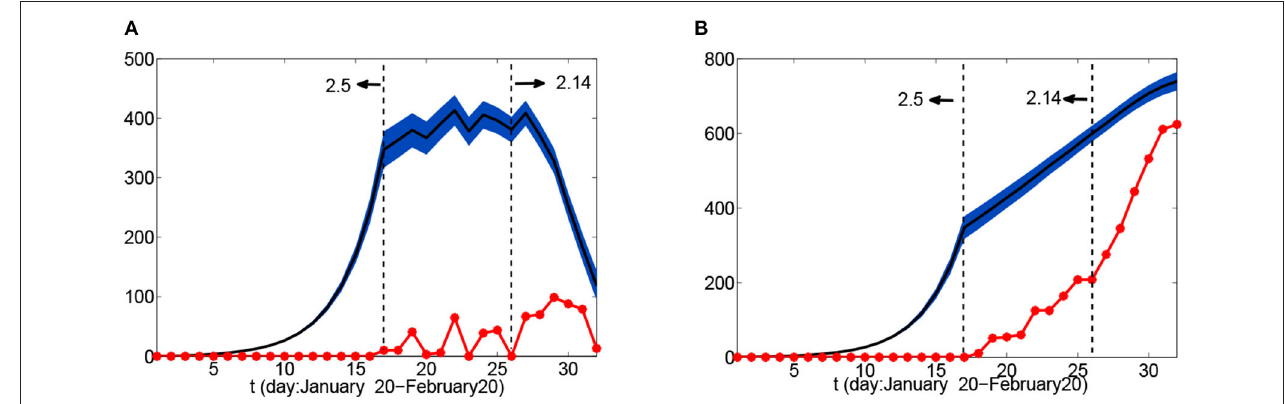
FIGURE 3 | Number of infected people as a function of time from January 20 to February 20 in Case I: (A) daily new number of infected cases; (B) daily cumulative number of infected cases. Red dots represent actual confirmed numbers; black dotted lines indicate critical time nodes; the black solid line represents the theoretical I ( t ) in (A) and A ( t ) in (B); the blue area represents the interval of 10,000 times deduction results. mean value of the number of infected, λ C ( t )( N − G ( t ) − I ( t )) N − G ( t )